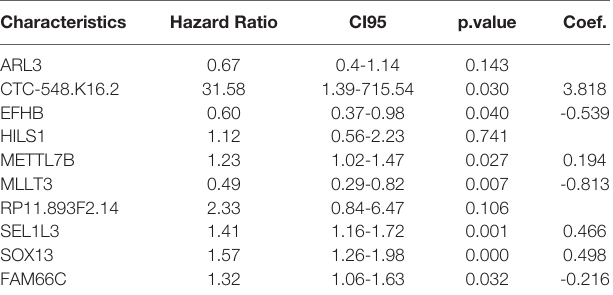
TABLE 1 | Multivariate Cox analysis was used to further screen prognostic factors and corresponding coef fi cients of the linear model. Characteristics Hazard Ratio p.value